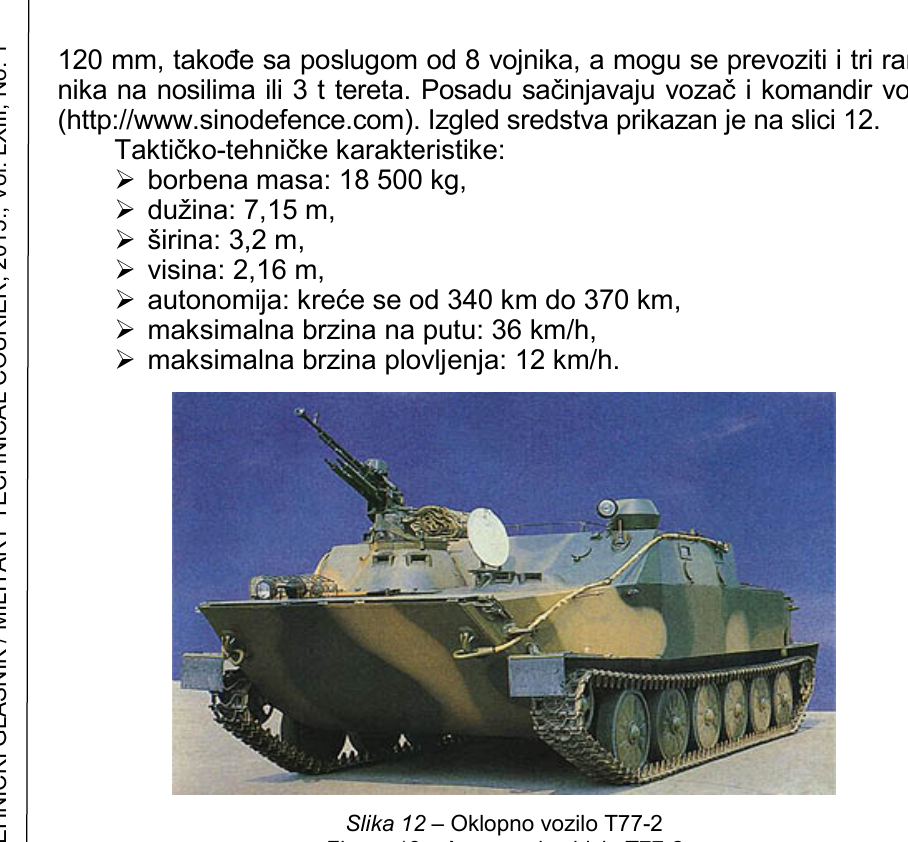
Figure 12 – Armoured vehicle T77-2